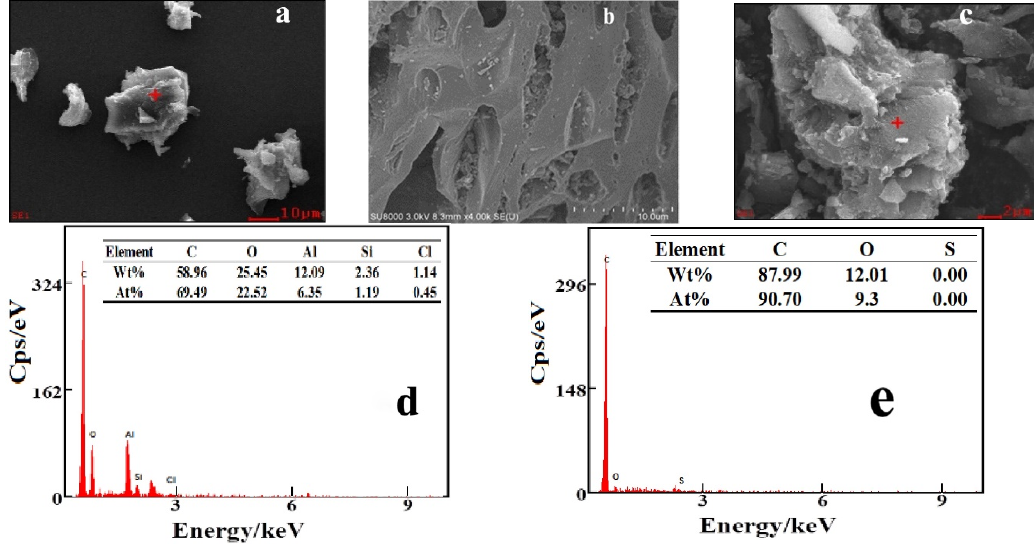
Figure 2. SEM and EDS maps of PACMC and PAC. ( a ) PACMC-SEM; ( b ) PACMC-SEM; ( c ) PAC-SEM; ( d ) PACMC-EDS; ( e ) PAC-EDS.